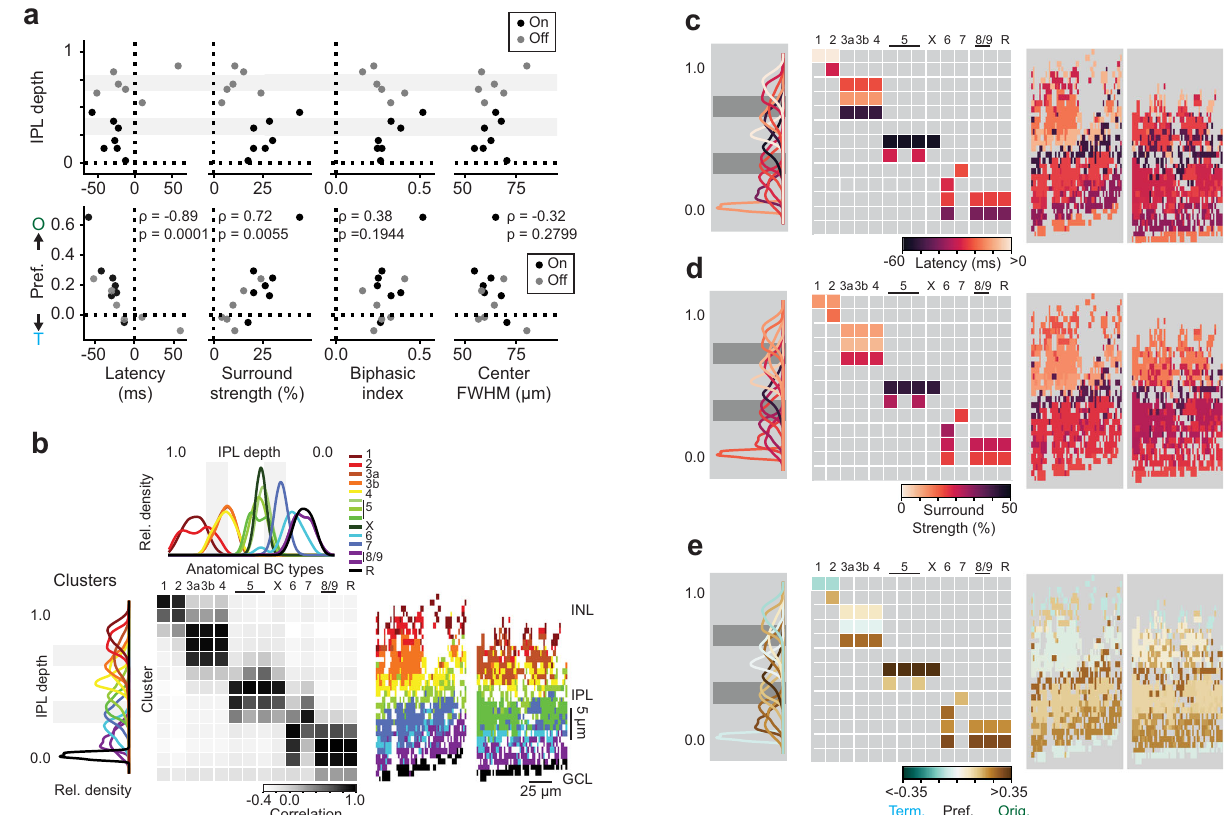
Fig. 3 | Layer-speci fi c radial direction selectivity depends on bipolar cell sur- round. a Center-surround properties of BCclusters from Fig. 2 plotted against IPL depth (top) or rDS preference of modeled responses (bottom). Black and gray points represent On and Off-type BCs, respectively; gray shading marks approx. ChAT bands. ρ indicates the Spearman correlation coef fi cient, with p-values listed (two-sided test). b Top: density plot of BC anatomical strati fi cation as reported earlier 18,19,30 . Left: density plot of BC cluster strati fi cation of ROIs from each cluster in Fig. 2. Colors chosen by likely matches with anatomical strati fi cation. Gray shading marks approx. ChAT bands. Middle: correlation between BC clusters and